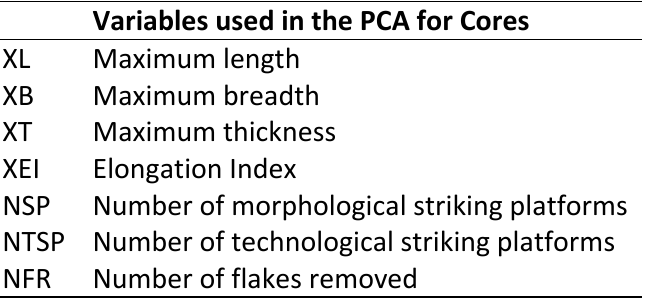
Table 3. Attributes for core